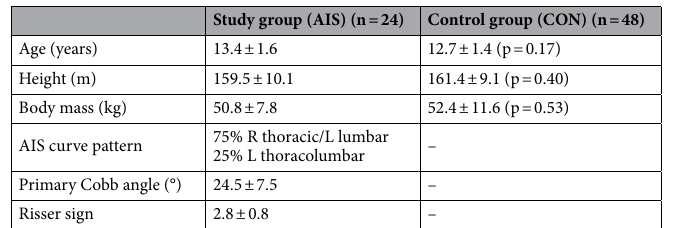
Table 1. Characteristics of the participants (mean ± SD). The p-values are the results of between-group comparison of the respective data ( t